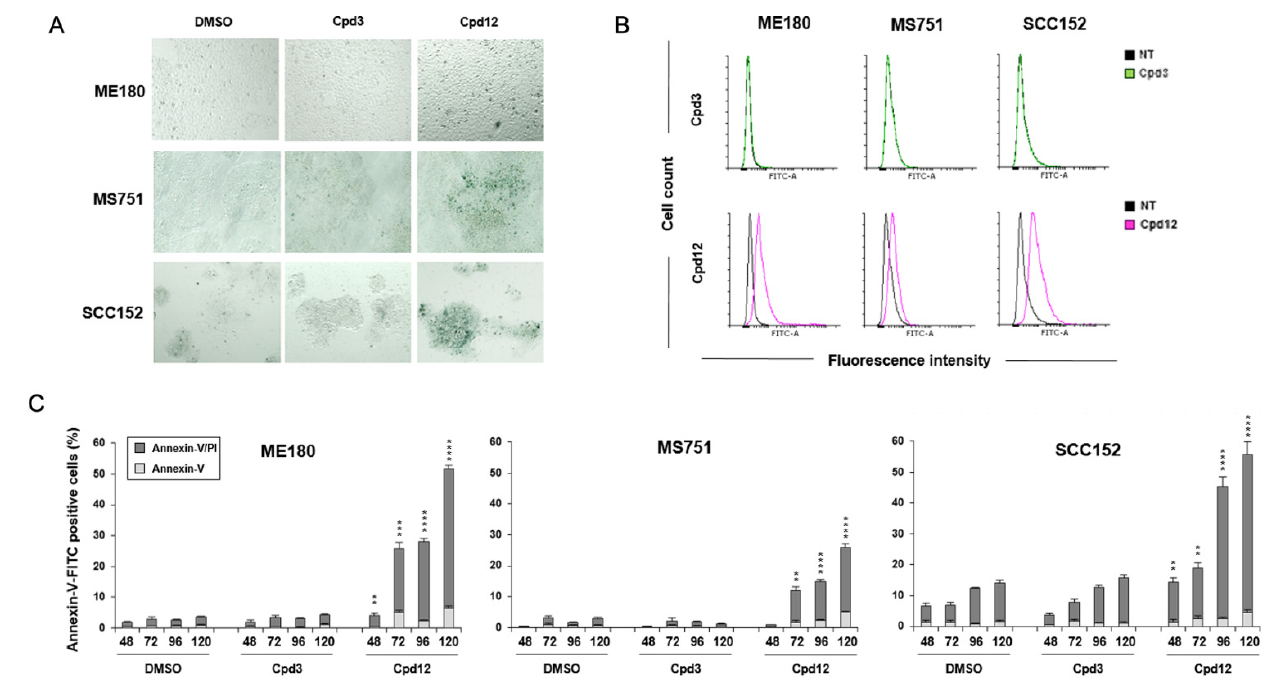
Figure 3. Cpd12 treatment induces senescent and apoptotic responses in both cervical and head- and-neck cancer cells. ( A ) SA- β -gal staining of ME180, MS751, and SCC152 cells treated with Cpd12. Representative images taken using a bright-field inverted microscope (100 × magnification) are shown. ( B ) Autofluorescence ofME180, MS751, and SCC152 cancer cells was assessed by flow cytometry after treatment with Cpd12 as described in Methods. Histograms are representative of one out of three independent experiments. ( C ) Apoptosis induction in ME180, MS751, and SCC152 cells treated with Cpd12 for 48, 72, 96, and 120 h. Values in the bar graphs represent the mean ± SD of at least three independent experiments. Data were analyzed by a two-way ANOVA followed by Tukey’s multiple comparison test; **, p < 0.01; ***, p < 0.001; ****, p < 0.0001, Cpd12 versus DMSO. In all panels, cells treated with the inactive small molecule Cpd3 or DMSO were included as negative controls.